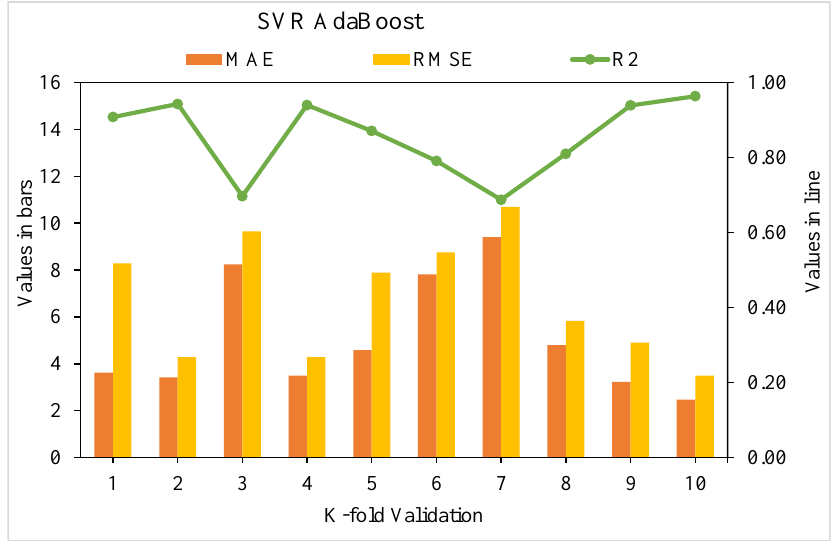
Figure 10. K-fold cross-validation representation for the AdaBoost model.